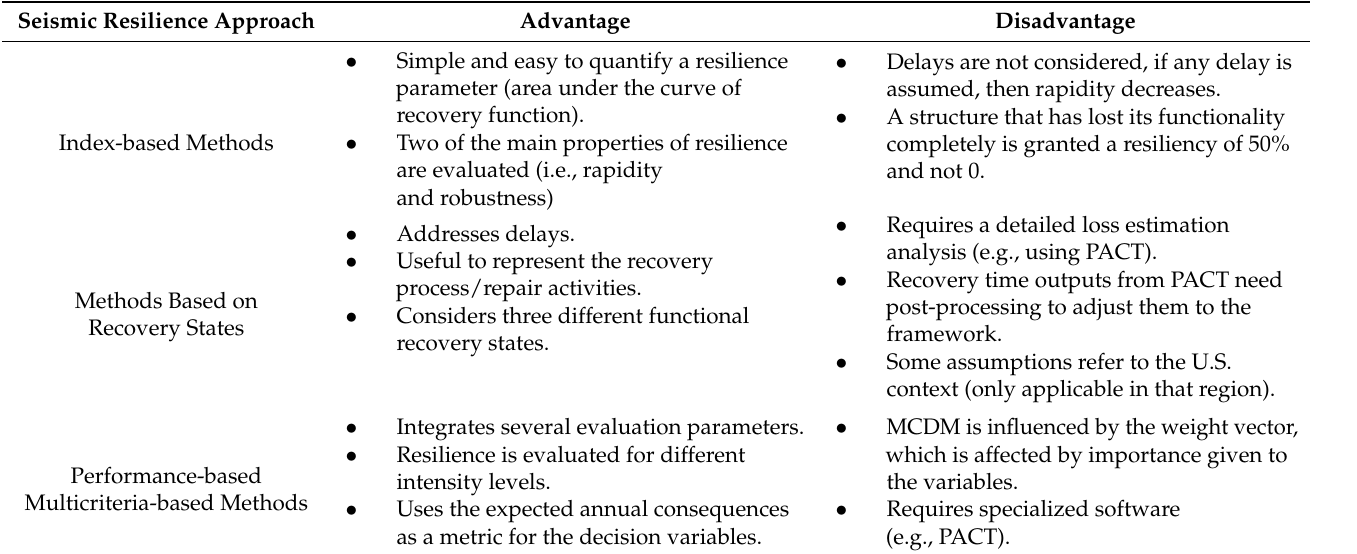
Table 1. Main advantages and shortcomings of the reviewed